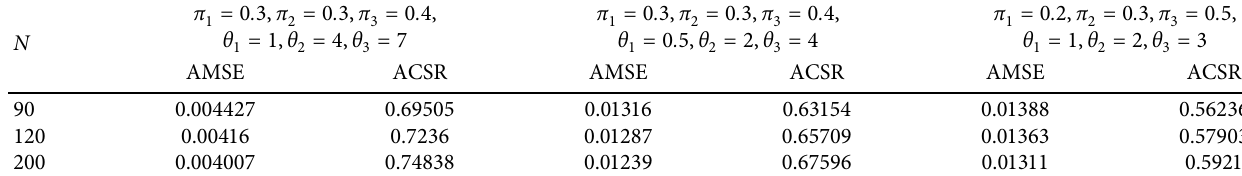
Table 2: Te results of AMSE and ACSR of applying the EM algorithm to simulated data from the three-component mixture model for three diferent scenarios and three diferent sample sizes with 1000 replications.